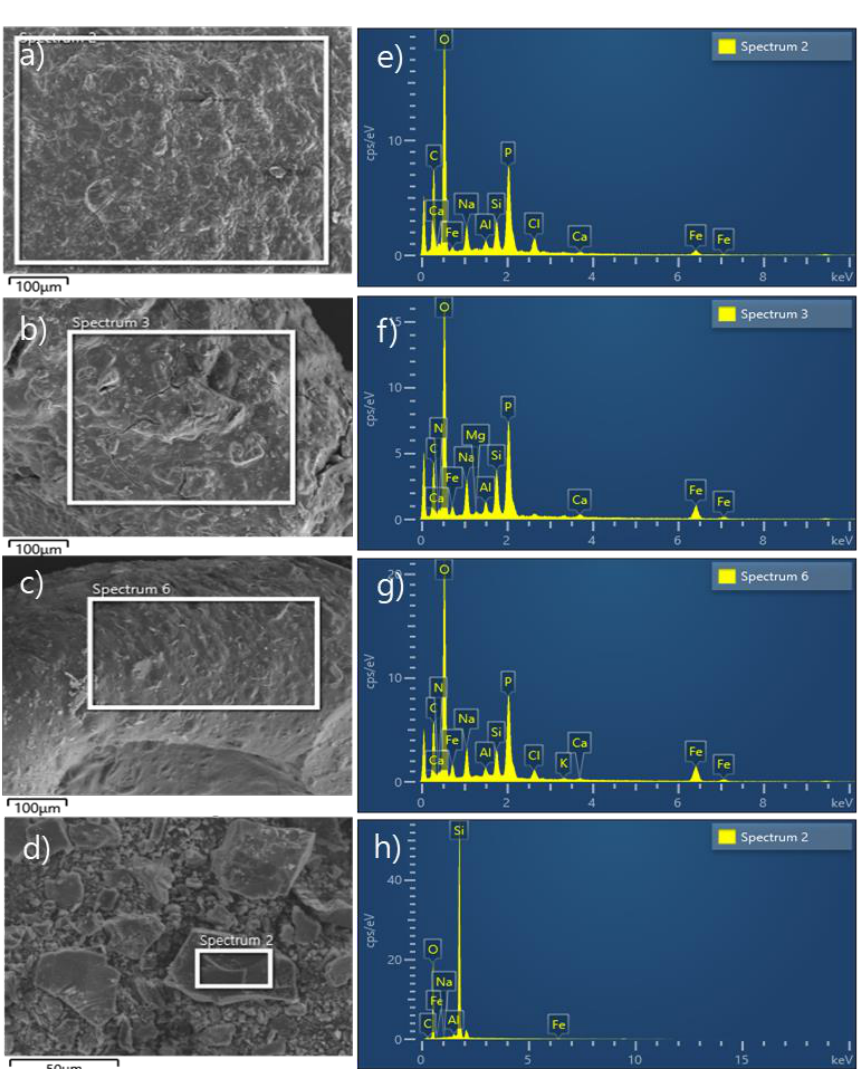
Figure 2. SEM images ( a – d ) and EDS spectra ( e – h ) of the SCM beads and SP: ( a , e ) bead 1/1/0.1; ( b , f ) bead 1/1/0.3; ( c , g ) bead 1/1/0.5; and ( d , h ) SP.